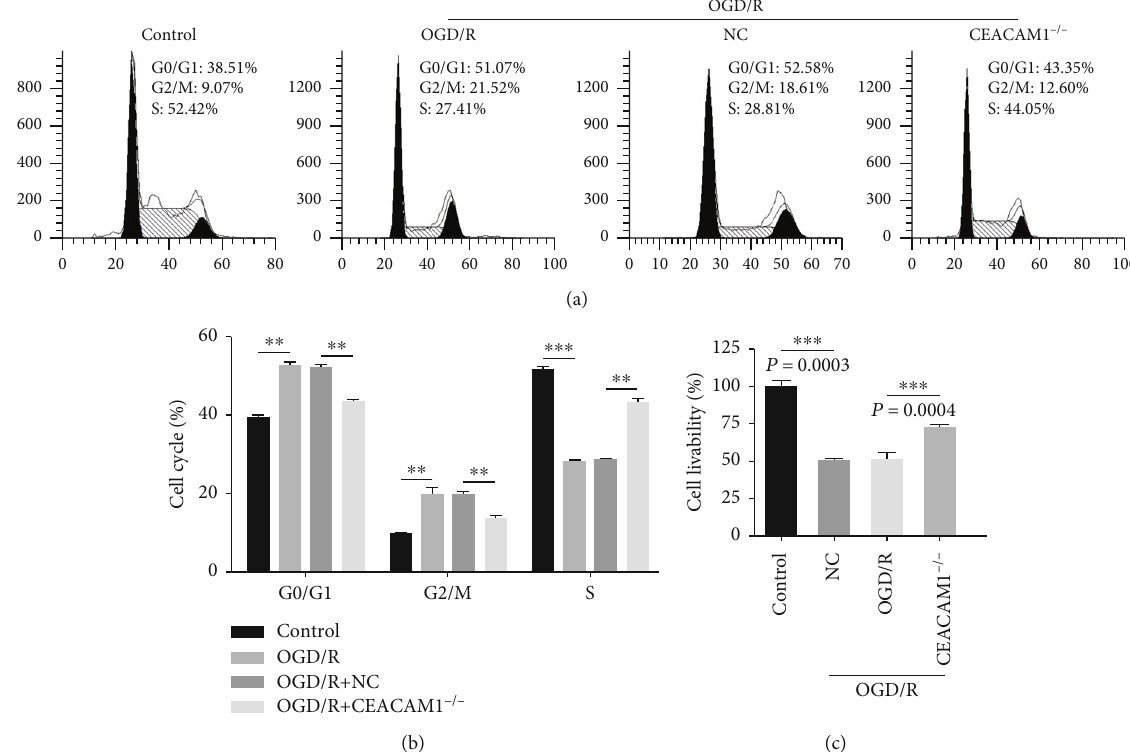
Figure 4: Cell cycle detection with fl ow cytometry and cell proliferation was measured through CCK8 assays. (a) More of the HPMVECs grown under OGD/R conditions were found to be in G0/G1 or G2/M phase, while fewer were in S phase than in the control group. (b) The cell number of CEACAM1 -/- group in G0/G1 or G2/M phase was reduced, while S phase increased compared to the NC group. (c) The cell viability measured by CCK8 assays of OGD/R group did not di ff er from the NC group, but was signi fi cantly lower than the CEACAM1 -/-